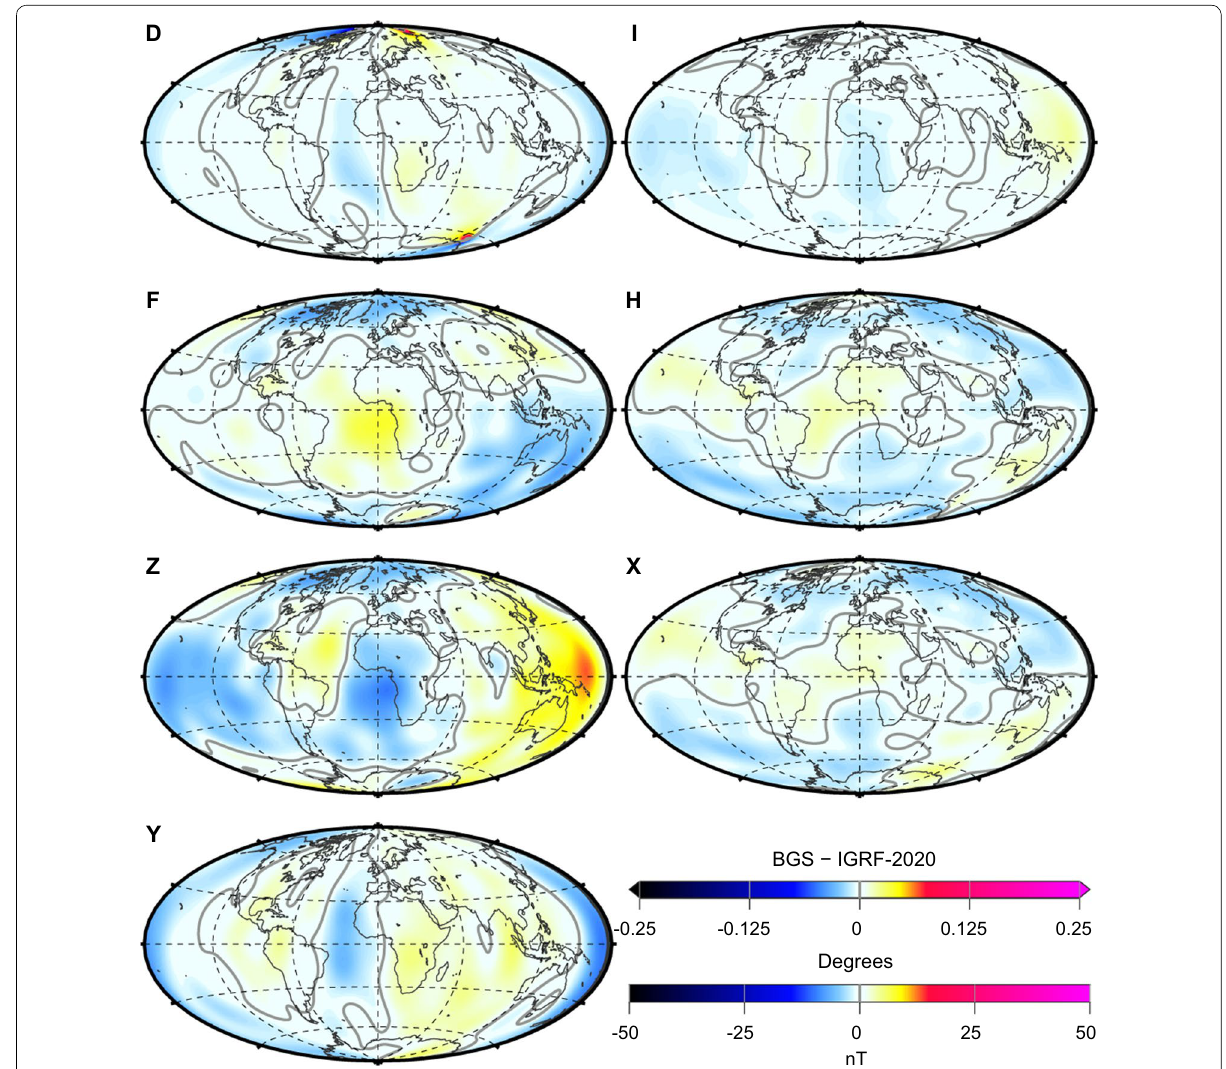
Fig. 6 Difference in each magnetic component between the BGS candidate model for 2020.0 and IGRF-2020 (median of IGRF-13 candidates). Values of contours (grey lines) are marked on the colour scales, with a thicker line for the zero